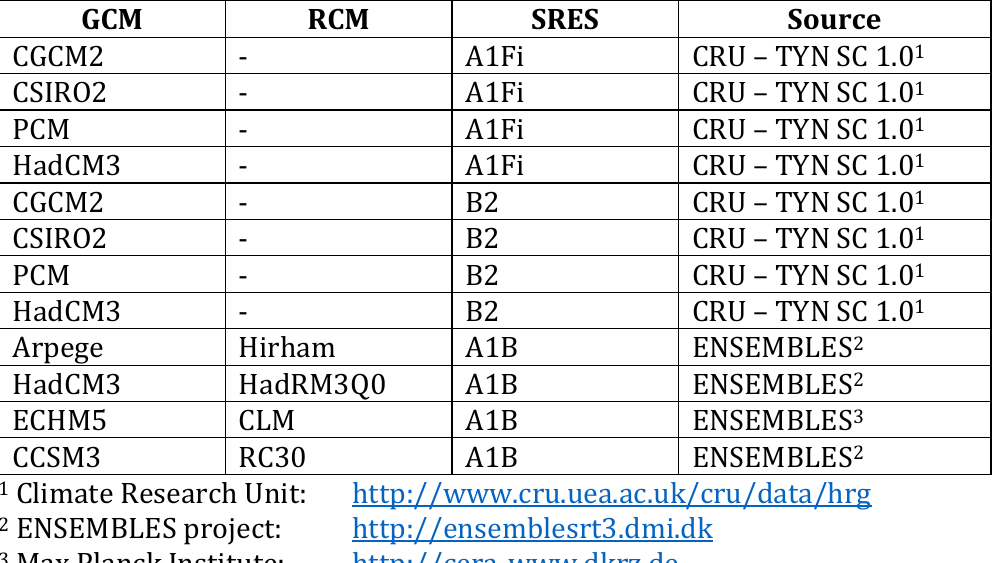
Table A1.1 List of climate models used in the simulation of case studies. Both GCM and RCM models are used to realize the climate change scenarios using multiple sources (Source: Hanewinkel et al. 2013).